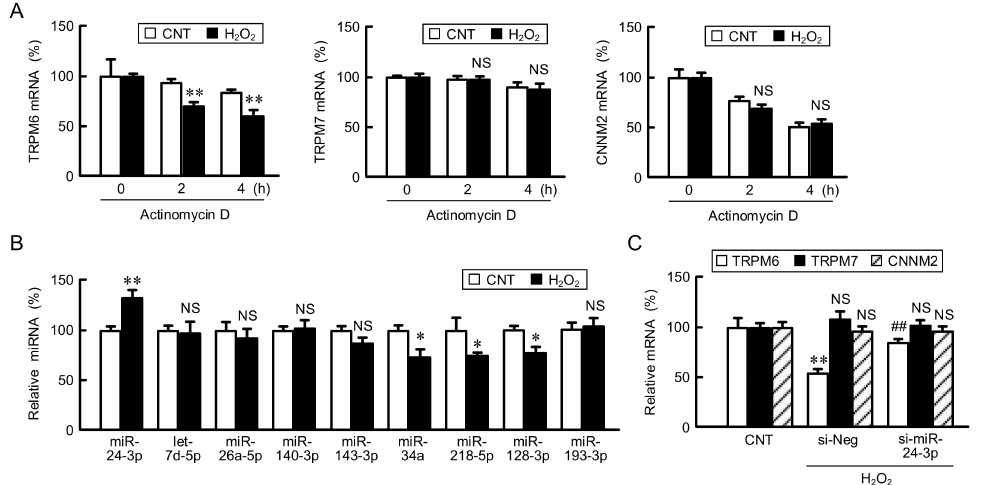
Figure 3. Involvement of miR-24-3p in the decrease in TRPM6 mRNA by H 2 O 2 . ( A ) NRK-52E cells were treated with actinomycin D in the presence or absence (CNT) of H 2 O 2 for the periods indicated. The mRNA levels of TRPM6, TRPM7, and CNNM2 were represented as percentage of 0 h. ( B ) Cells were treated in the presence or absence (CNT) of H 2 O 2 for 6 h. The miRNA levels were determined by real time PCR and compared with CNT. ( C ) The cells transfected with negative (si-Neg) or miR-24-3p siRNA (si-miR-24-3p) were treated with H 2 O 2 for 6 h. The mRNA levels of TRPM6, TRPM7, and CNNM2 were represented as percentage of CNT. n = 3–4. ** p < 0.01, * p < 0.05 and NS p > 0.05 compared with CNT or 0 µ M. ## p < 0.01 compared with